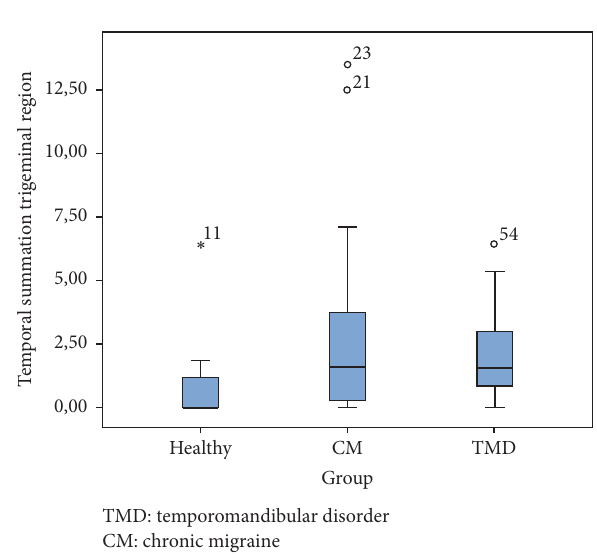
Figure 1: Boxplot for temporal summation in the trigeminal region.